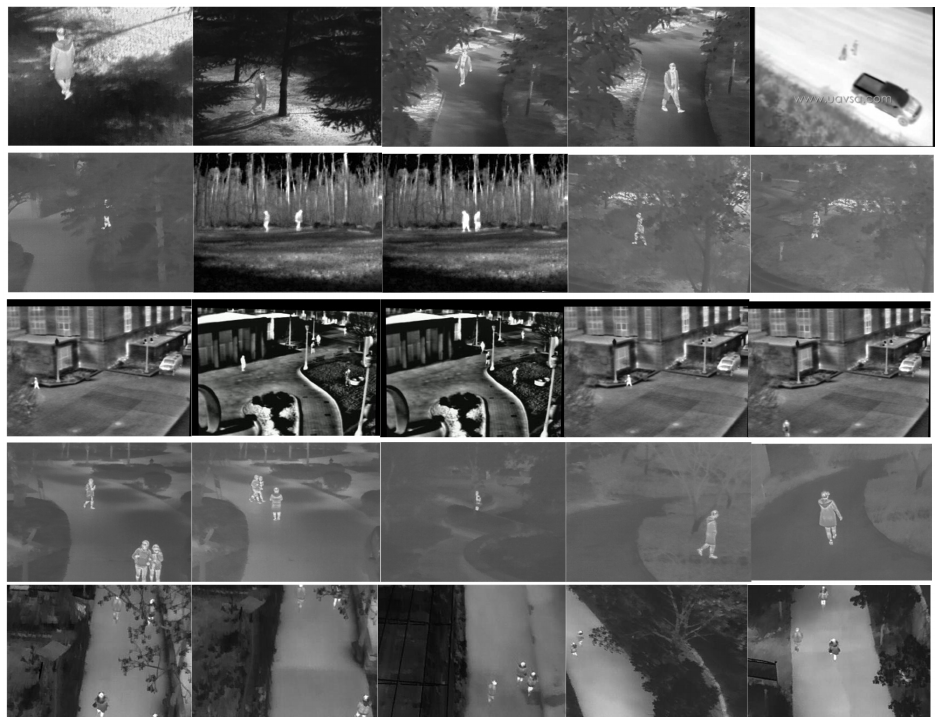
Figure 4. The instance pictures of the AIR-pedestrian dataset. Each row from top to bottom represents the scene of daytime, woods, buildings, gardens, and roads, respectively.